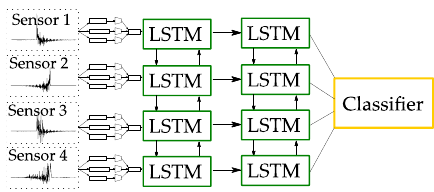
Figure 11. Multi-resolution CNN and LSTM fusion structure proposed by [24] .